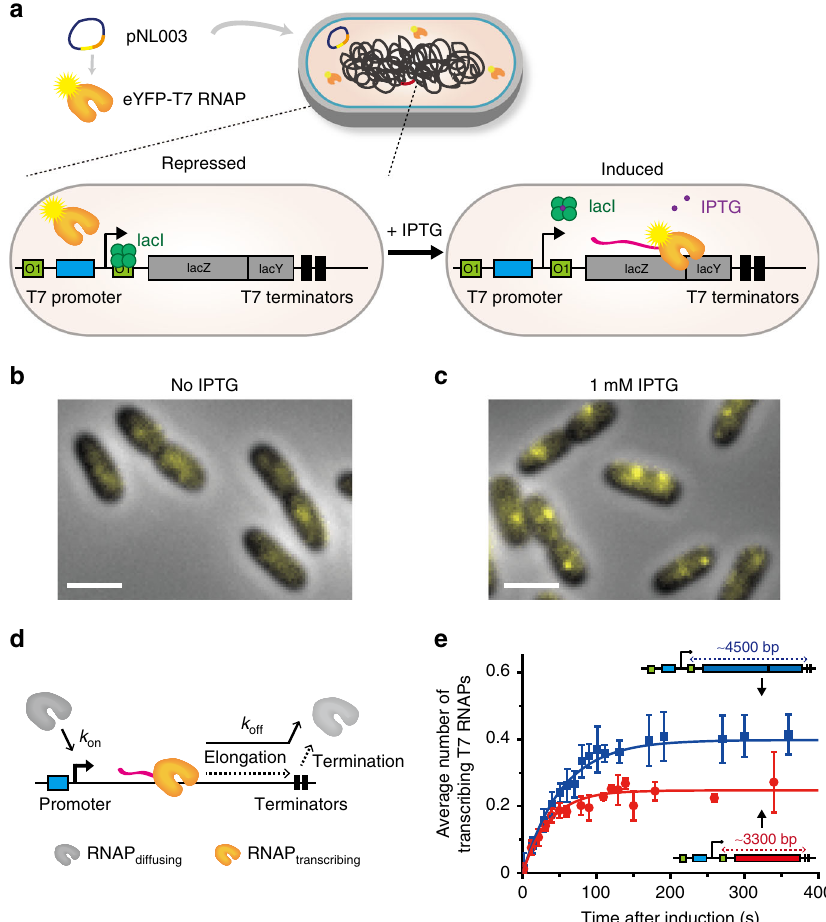
Fig. 1 Transcription by T7 RNAP in living E. coli cells was observed by single-protein detection. a A schematic illustration of the gene system used to visualize single eYFP-T7 RNAPs during transcription. eYFP-T7 RNAP is expressed from an L -rhamnose inducible plasmid (pNL003). The left panel represents the repressed condition, in which the binding of LacI proteins on two Lac operators (O1) blocks transcription by RNAP. The right panel represents the induced condition, in which LacI proteins dissociate from their operators with the addition of 1 mM IPTG and RNAP thus binds to the T7 promoter and generates mRNAs. b , c Representative images of eYFP-T7 RNAPs in E. coli cells. Scale bar, 2 μ m. b No IPTG. Blurred fl uorescent signals from the rapidly diffusing eYFP-T7 RNAP molecules were detected. c With 1 mM IPTG. The image was acquired at 303 s after adding IPTG. Diffraction-limited fl uorescent foci of eYFP-T7 RNAP were clearly observed. d A kinetic model of in vivo transcription. k k on denotes the transcriptional on-rate, and off denotes the transcriptional off-rate (Supplementary Note 1). e Average number of transcribing eYFP-T7 RNAPs during transcription per cell after IPTG induction, including cells that exhibit no bright spots. The blue fi lled squares and the red fi lled circles denote data from the induction of the T7p_4.5 kb and T7p_3.3 kb strains, respectively. The data were fi tted to a single exponential function, a (1 − exp( − bt )), where a = k ’ on × [RNAP total ]/ k off and b = k off . The elongation rate of RNAP equals L gene length × k off . The average total number of T7 RNAPs, [RNAP total ], in a cell was 35. The data represent mean ± s.d. (standard